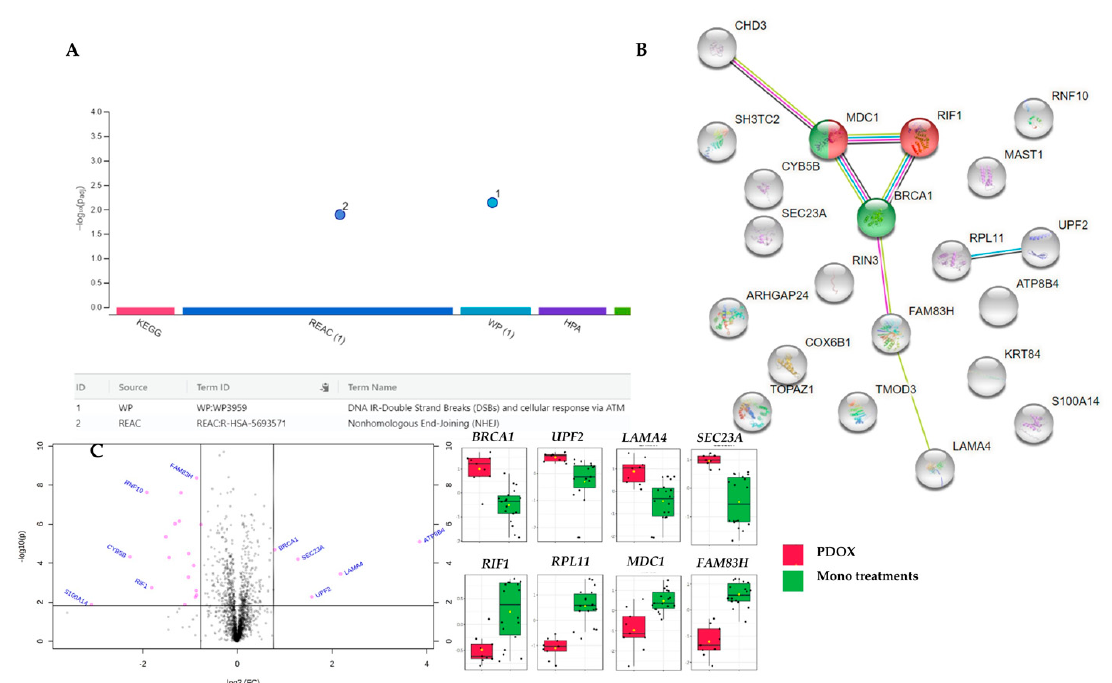
Figure 9. ( A ) Enriched pathways using g:Profiler, ( B ) STRING network of the differentially expressed proteins in the synergistic combination-treated MCF7 cells and ( C ) Volcano plot of 0.015 p -value and absolute 1.7 FC threshold among identified proteins in the synergistic combination-treated cells with selected proteins expression summary (PDOX = synergistic combination of AP-1 and DOX). BRCA1-A complex and BRCT domain associated proteins in red and green, respectively, in STRING network. WP; Wikipathways, REAC;